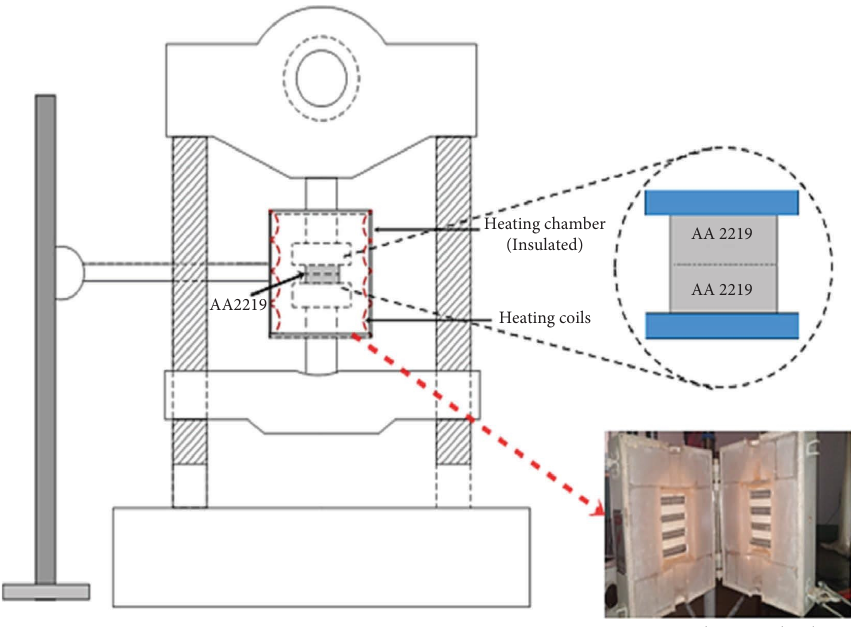
Figure 1: Schematic representation of the customized difusion bonding equipment.